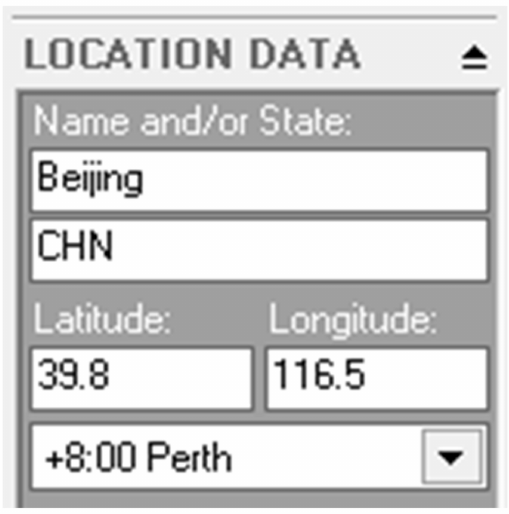
Figure 10. Importing meteorological